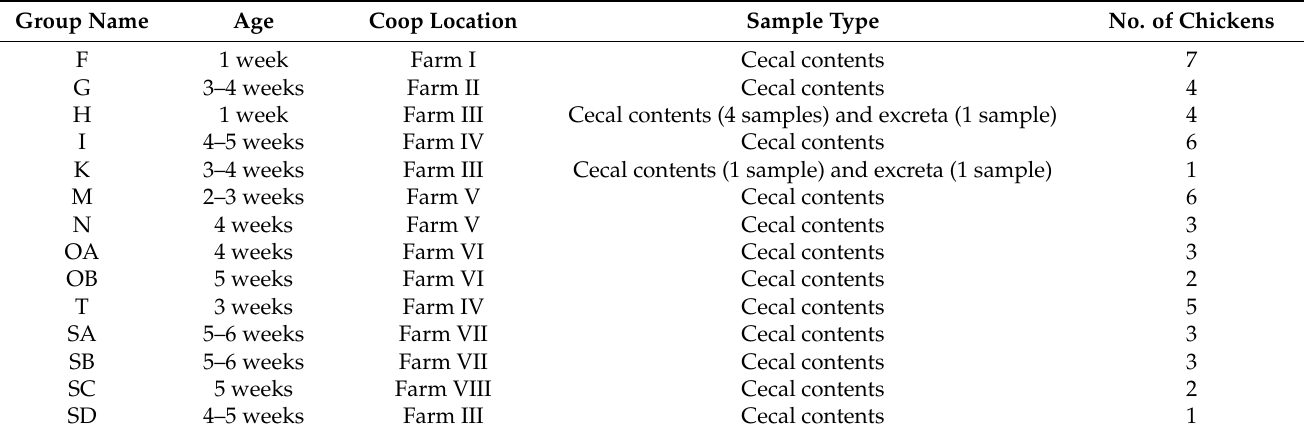
Table 4. Groups of commercial chickens.